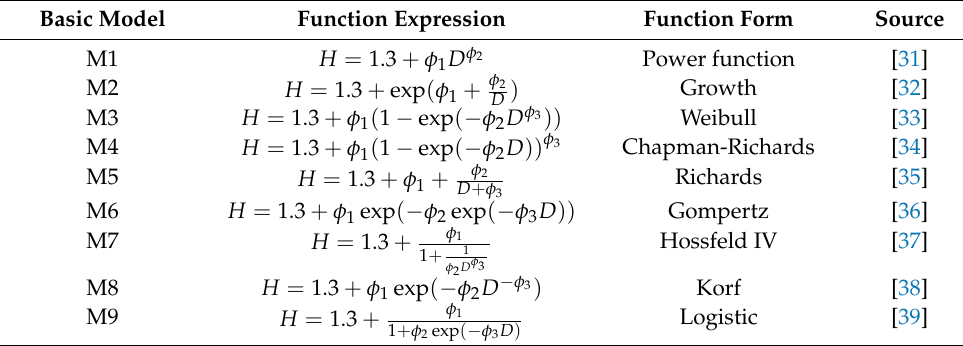
Table 4. Candidate base models we